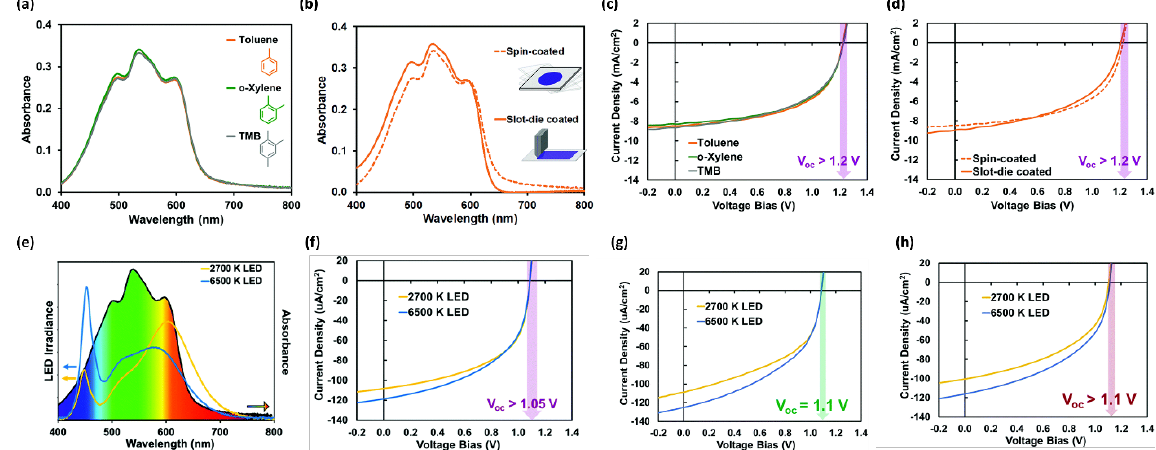
Figure 15. ( a ) UV–Vis absorption spectra of PTQ10:tPDI 2 N-EH (1:1) blend film from a toluene, o -xylene, or TMB solvent containing 1% ( v / v ) DPE, ( b ) UV–Vis absorption spectra of spin-coated and slot-die-coated films of the PTQ10:tPDI 2 N-EH (1:1)blend film from a 10 mg/mL and 15 mg/mL toluene solution, respectively, containing 1% ( v / v ) DPE, ( c , d ) the corresponding device J–V curves, respectively, under 1 sun illumination, ( e ) irradiance spectra of 2700 K and 6500 K LED, acting as the illumination source for the low-light intensity iOPV measurements. The optical absorption spectrum of the slot-die-coated blended film of the PTQ10:tPDI 2 -EH (1:1) from a 15 mg/mL toluene solution containing 1% ( v / v ) DPE is superimposed to show the match between the emission spectrum of the LED and the absorption spectra of the blend, ( f ) device J–V curves of the corresponding OPVs tested under LED illumination of ca. 2000 lux (568 and 610 µW/cm 2 for 2700 K and 6500 K, respectively), and ( g ) device J–V curves of OPVs with PTQ10:tPDI 2 N-EH BHJs coated on top of ITO/ZnO/PDICA, and ( h ) device J–V curves of the ternary OPVs with PTQ10:tPDI 2 N-EH:PDI-EDOT-PDI (1:0.8:0.2) BHJs under 2000 lux LED illumination [85]. ( a – h ) reproduced with permission from [85]. Copyright 2020 Royal Society of Chemistry.